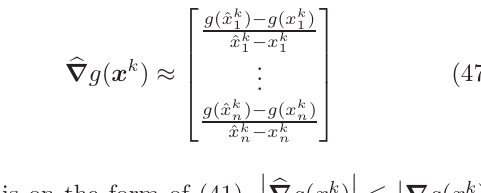
Figure 3: A simple path in the xy -plane. The dotted lines show two examples on how the cross section of the visualising quaternion volume in Section 8 can be